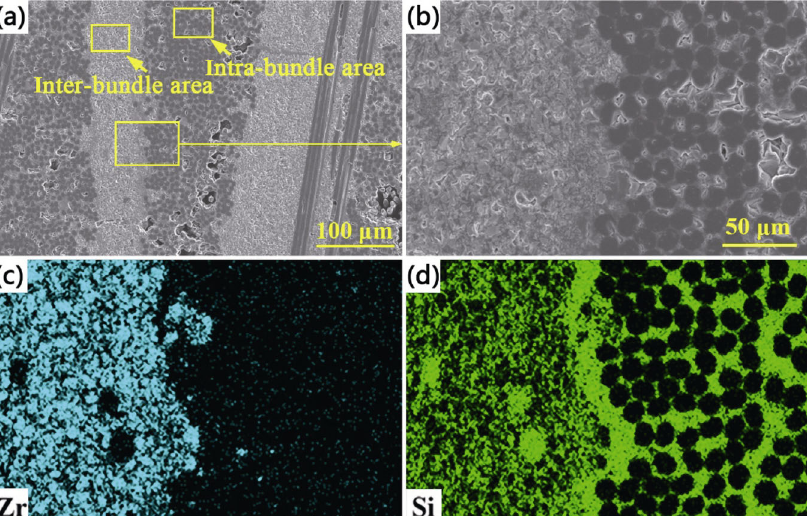
Fig. 21 Microstructures of 2D-C f /ZrB 2 –SiC composites (a, b), and the EDS analysis of (b) (c, d). Reproduced with permission from Ref. [198], © Elsevier Ltd.